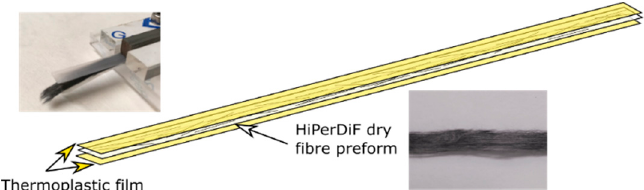
Figure 10. Preform before consolidation showing aligned 3 mm fibres sandwiches between polymer films.